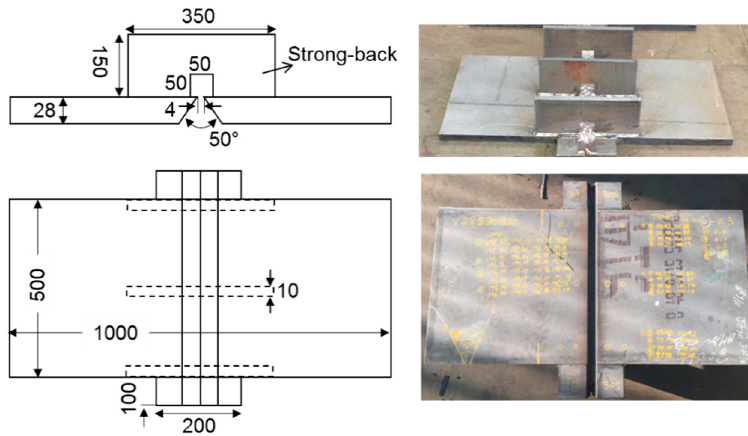
Figure 9. Specimen for V butt welding experiments (unit: millimeters).